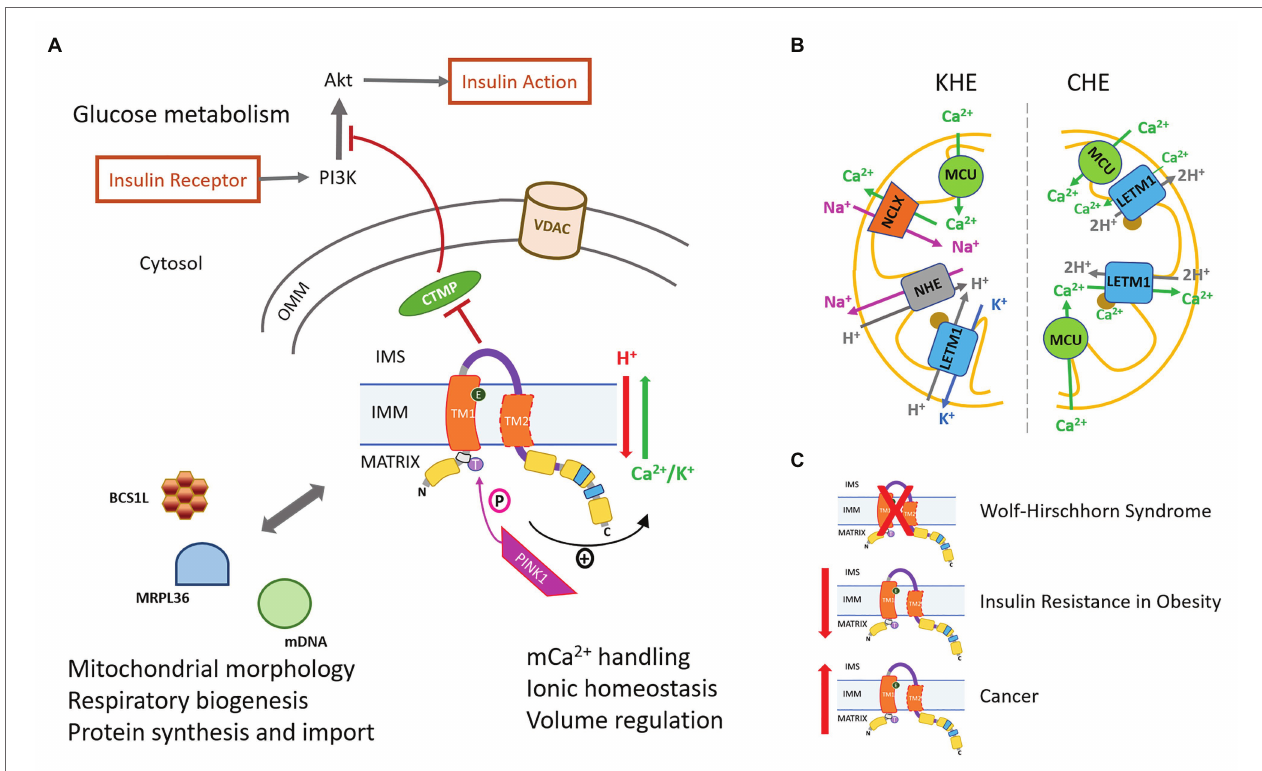
FIGURE 2 | LETM1-mediated regulation of cellular physiology and pathophysiology. (A) LETM1-mediated Ca 2+ /H + exchanger (CHE) or K + /H + exchanger (KHE) activity regulates mitochondrial Ca 2+ handling and bioenergetics. The serine-threonine kinase PINK1, associated with Parkinson’s Disease (PD), phosphorylates LETM1 at T192 and enhances exchanger activity (see text for more details). Interactions of LETM1 with signaling proteins, such as CTMP, BCS1L, and MRPL36, regulate glucose metabolism, mitochondrial morphology, and protein assembly in the inner mitochondrial membrane (IMM), respectively. VDAC, voltage-dependent anion channel (B) Proposed mechanisms of LETM1 as KHE (left) or CHE (right). The brown circle represents EF-hand in mammalian LETM1. (C) Disease phenotypes associated with either the absence [Wolf-Hirschhorn Syndrome (WHS)], decreased expression (Insulin resistance in obesity), or increased expression (cancer) of